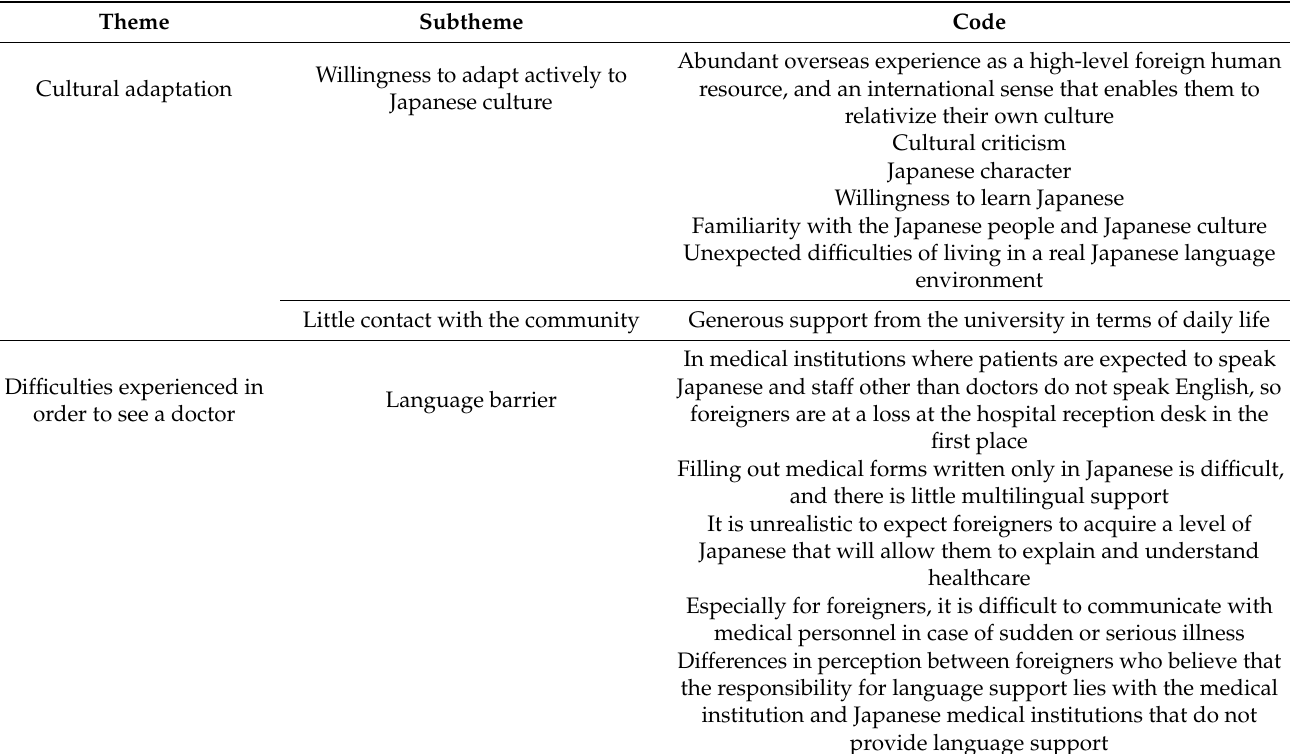
Figure 1. Overview of themes and subthemes extracted from participant experiences with healthcare in Japan. Double-headed arrows indicate conflict; single-headed arrows indicate causality. Table 3. Difficulties with receiving medical examinations in Japan as perceived by participants.